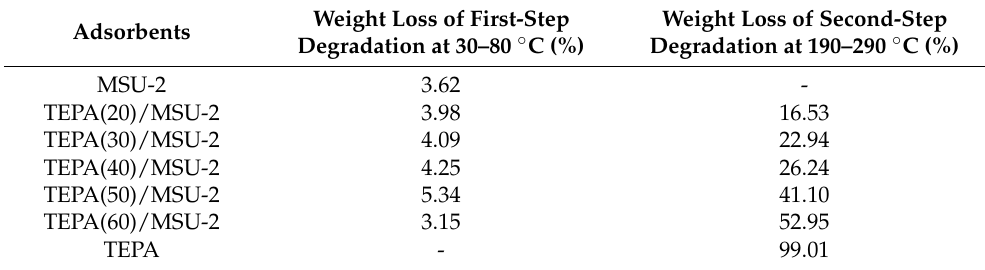
Table 3. Weight losses in TGA profiles of unfunctionalized and TEPA-functionalized MSU-2. Weight Loss of First-Step Adsorbents Degradation at 30–80 °C (%)